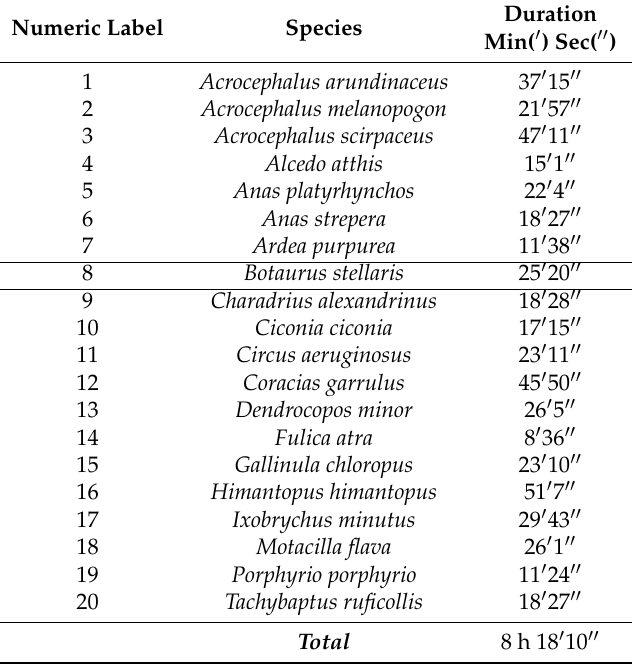
Table 2. Total duration of the data set used with the most populated species in The Parc Natural dels Aiguamolls de l’Empordà.